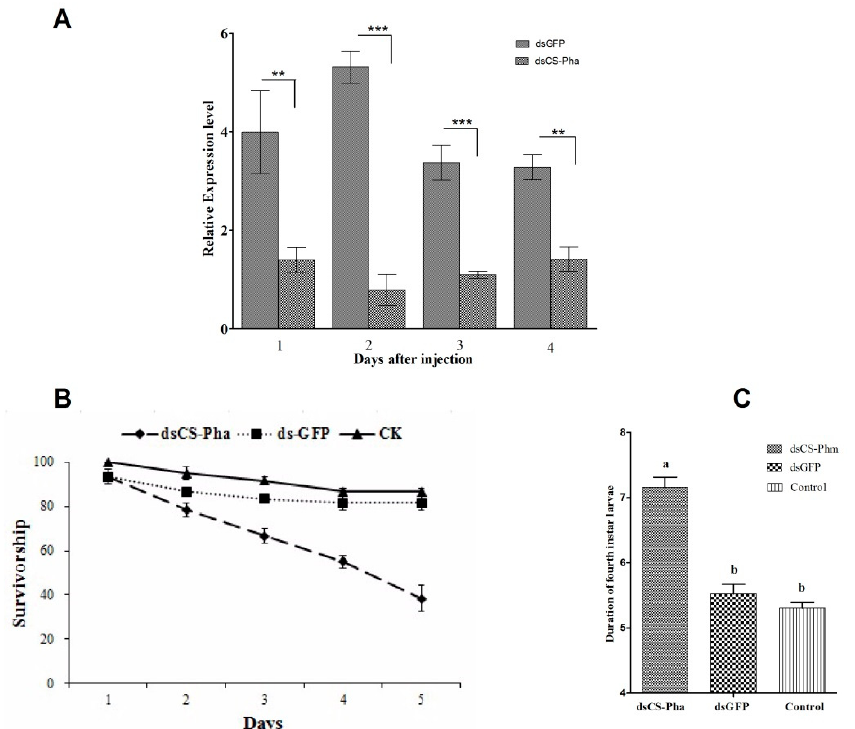
Figure 6. Effects of ds Cs-Phm injection on the ( A ) relative expression of Cs-phm ( B ) larval survival ( C ) and larval development of rice striped stem borer, C. suppressalis. ds Cs-Phm was injected on day 2 in 4th-instar larvae. The relative transcript level of Cs-Phm was measured after 1, 2, 3, and 4 days after ds Cs-Phm injection. Each sample collected for Cs-Phm relative expression measurement contained two larvae. The larval survival and larval development in 4th-instar larvae was calculated from three batches with 40 individuals in each batch. The columns indicate average values, and vertical bars represent SE. ** and *** indicate statistical differences between treatments at p < 0.01 and p < 0.001, respectively. Different letters in vertical bars represent significant differences at p value < 0.05.